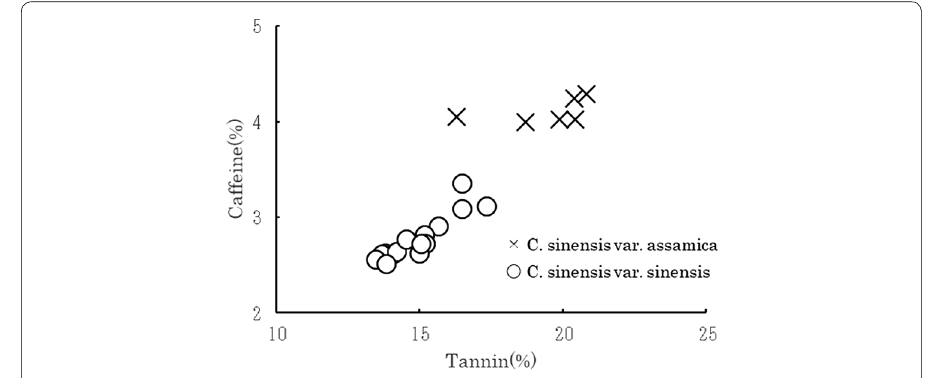
Fig. 4 Caffeine and tannins content for each gene group (Takeda